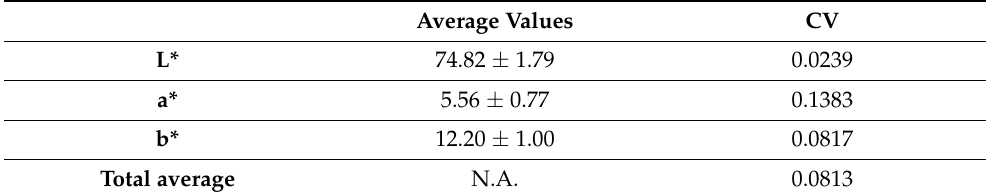
Table 6 . Average values for L*, a* and b* obtained before processing, with standard deviation and coefficient of variance (CV).